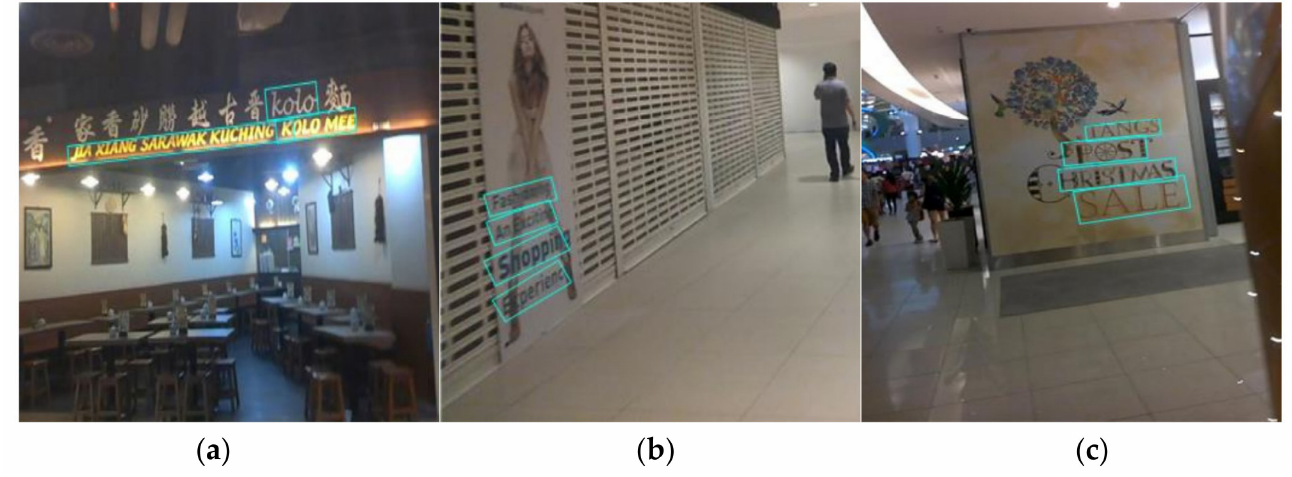
Figure 16. Text detection results of proposed improved EAST algorithm: ( a ) test image 1, ( b ) test image 2, and ( c ) test image